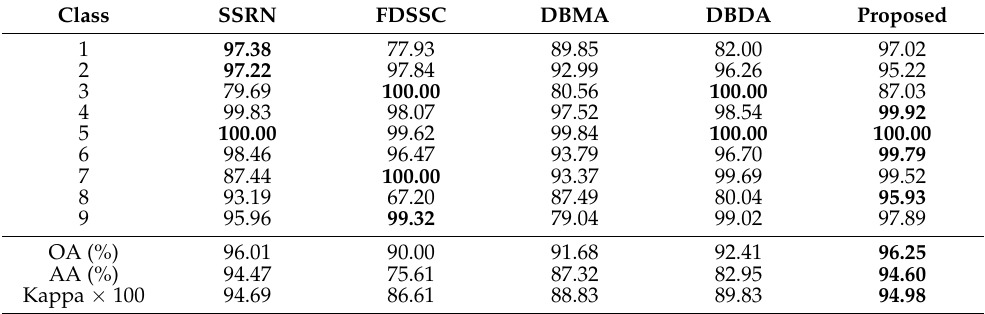
Table 8. Categorized results for the PU dataset.